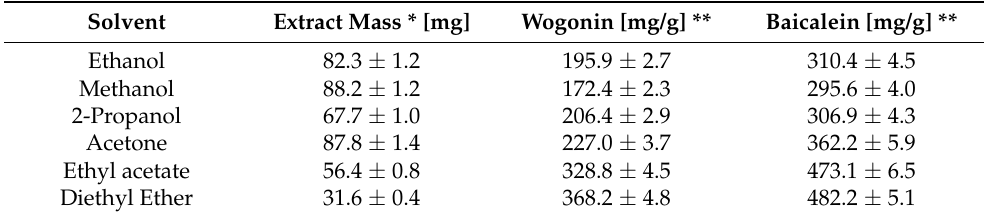
Table 2. Content of wogonin ( 4 ) and baicalein ( 3 ) in extracts obtained by using different solvents. Solvent Extract Mass *